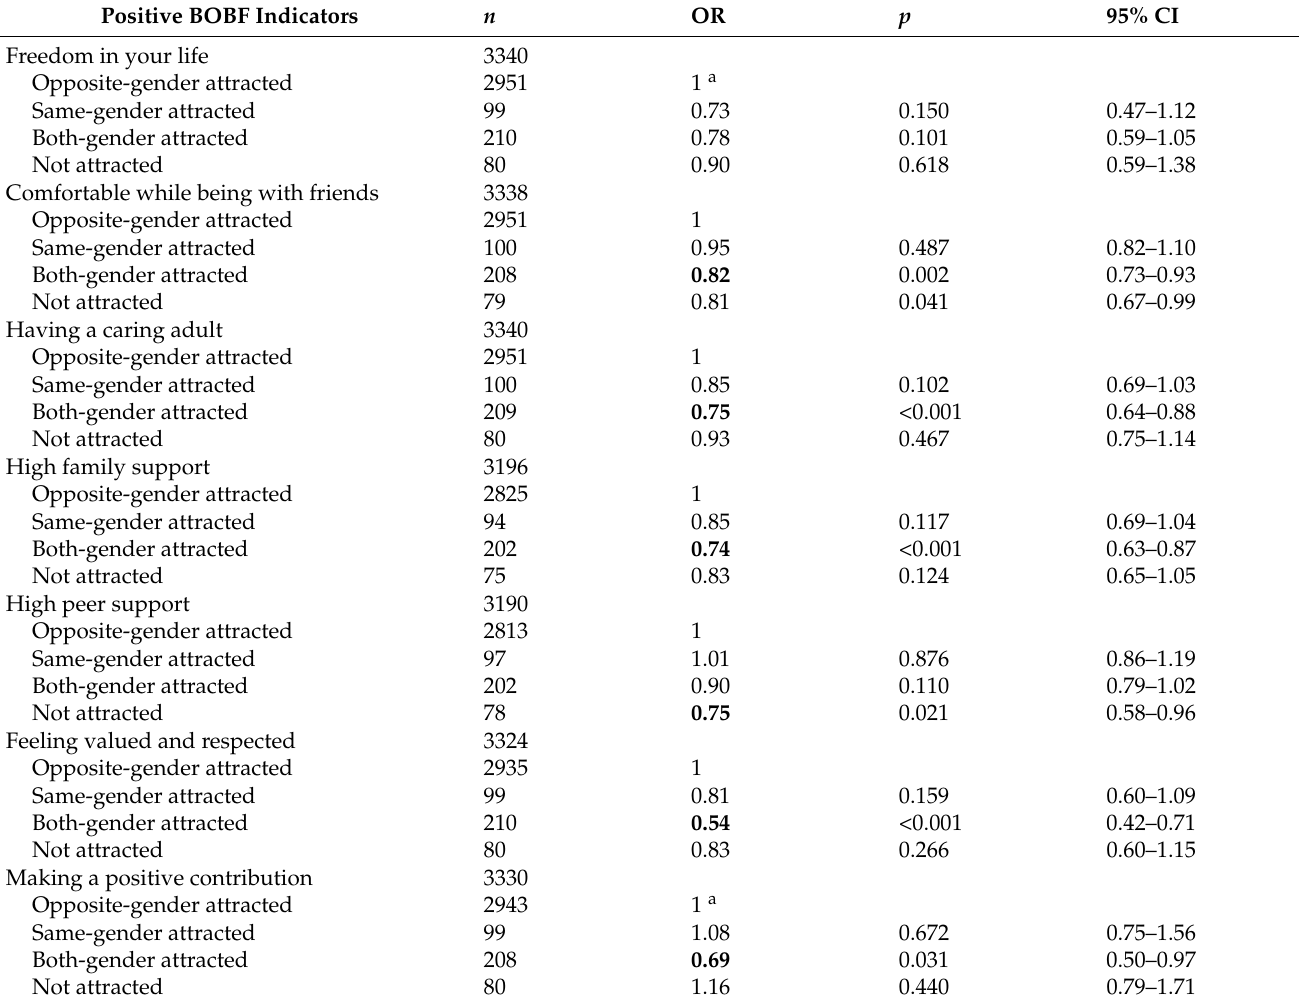
Table 5. Relative odds for same-gender attracted, both-gender attracted, and not attracted young people, compared to their opposite-gender attracted peers, to show positive outcomes on positive BOBF Outcome 5 indicators. Positive BOBF Indicators